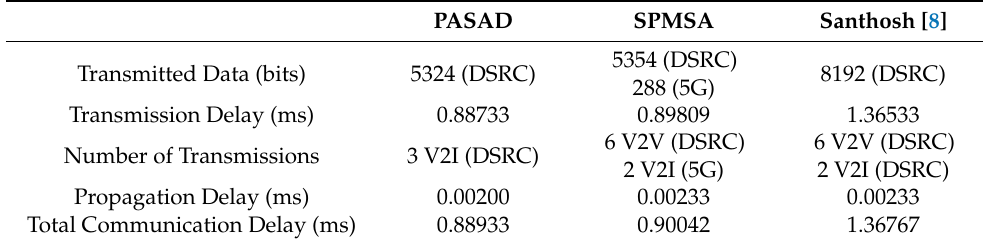
Table 2. Comparison of the Communication Delays of